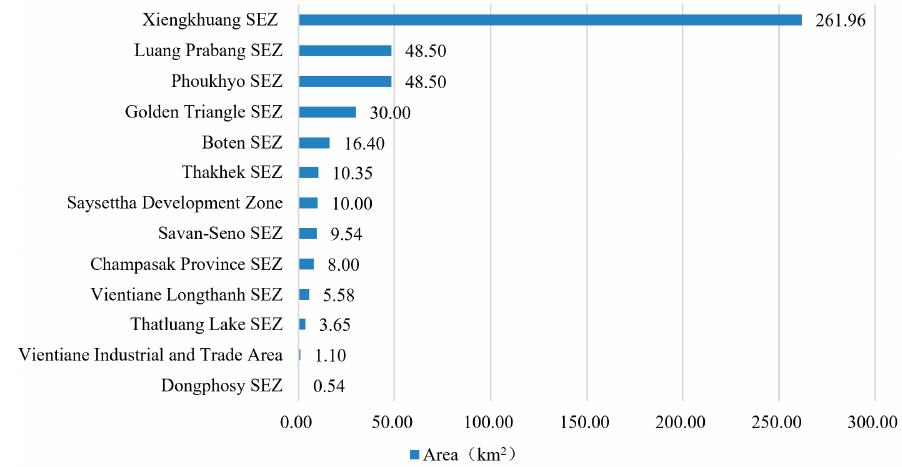
Figure 3. Area of the SEZs in Laos.